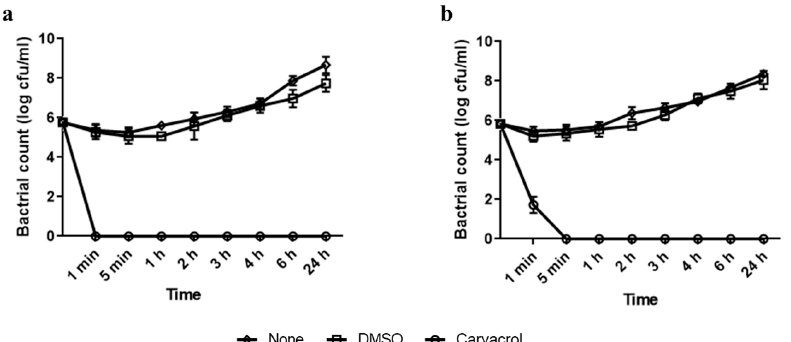
Figure 2. Time–kill assay curve from agar plate count method of carvacrol at MICs against plank- tonic cells of P. aeruginosa ( a ) and E. faecalis ( b ). Control containing DMSO was used. Results are presented as the means ( ± SD) of three independent experiments. “0” in the scale represents “below the detection limit”.